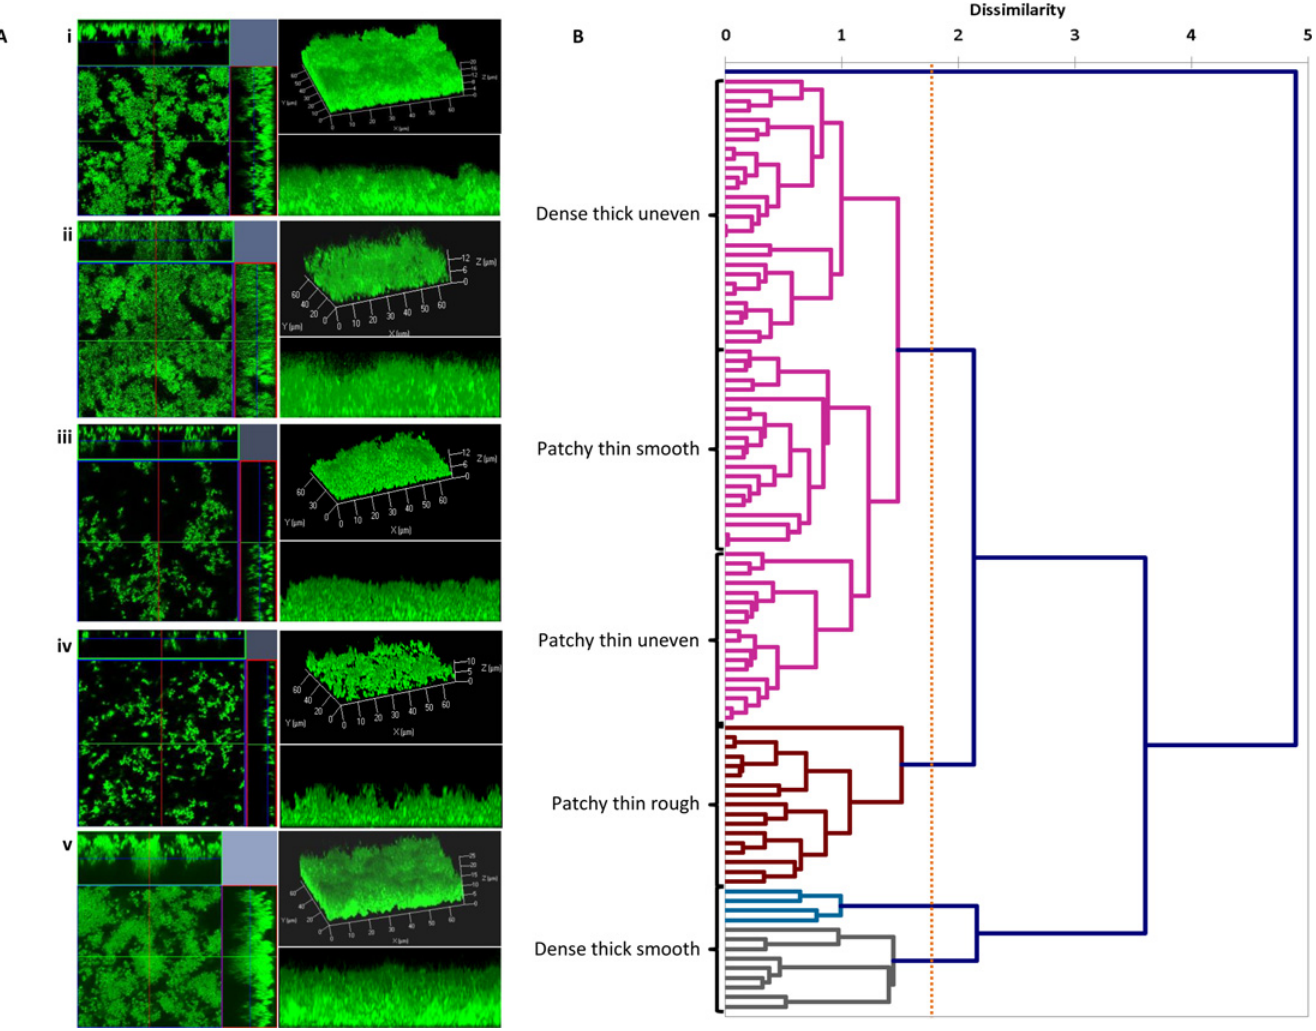
Fig 2. Confocal laser scanning microscopy (CLSM) biofilm images from different isolates and agglomerative hierarchical clustering (AHC) dendrogram labelled with biofilm morphotypes. (A) Example of CLSM images comprising orthogonal view of Z-stacks (left panel), 3D image of the Z- stacks (top right panel), and 3D cross-section of Z-stacks (bottom right panel). Scale of in μ m. (B) Each set of images corresponds to a biofilm structure group defined according to CLSM measurements (average thickness and roughness coefficient) (i) dense thick uneven; (ii) patchy thin smooth; (iii) patchy thin uneven; (iv) patchy thin rough; and (v) dense thick smooth. The AHC dendrogram is a multivariate cluster analysis examining the relationship between the biovolume, thickness and Ra measurements for the biofilms formed by each S . epidermidis isolate. The x-axis represents the dissimilarity score of merged